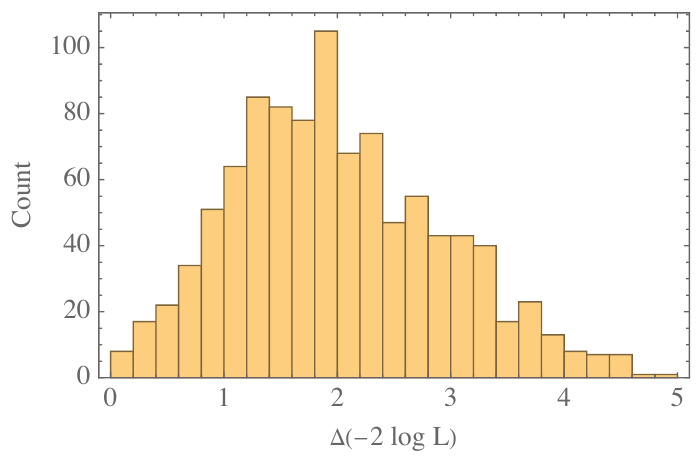
Figure 8 . Distribution of the log-likelihood ratio in the toy